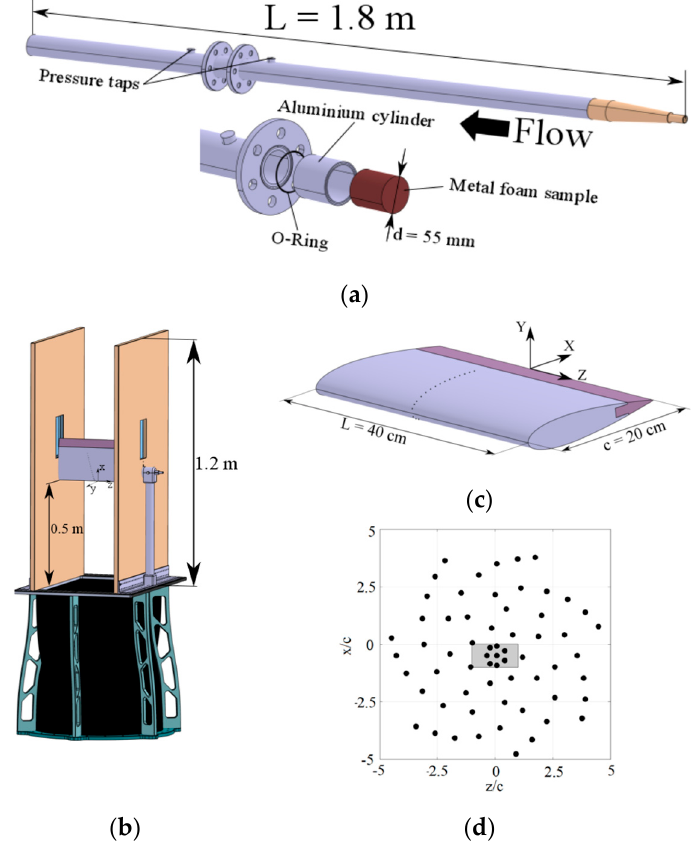
Figure 3. Setup of the ( a ) pressure measurement pipe for the permeability tests, ( b ) Wind tunnel schematics for the acoustic measurements, ( c ) the airfoil model dimensions, and ( d ) microphone array disposition (the grey part in the center represents the airfoil position with respect to the microphone array) drawings adapted from Rubio et al. [16].